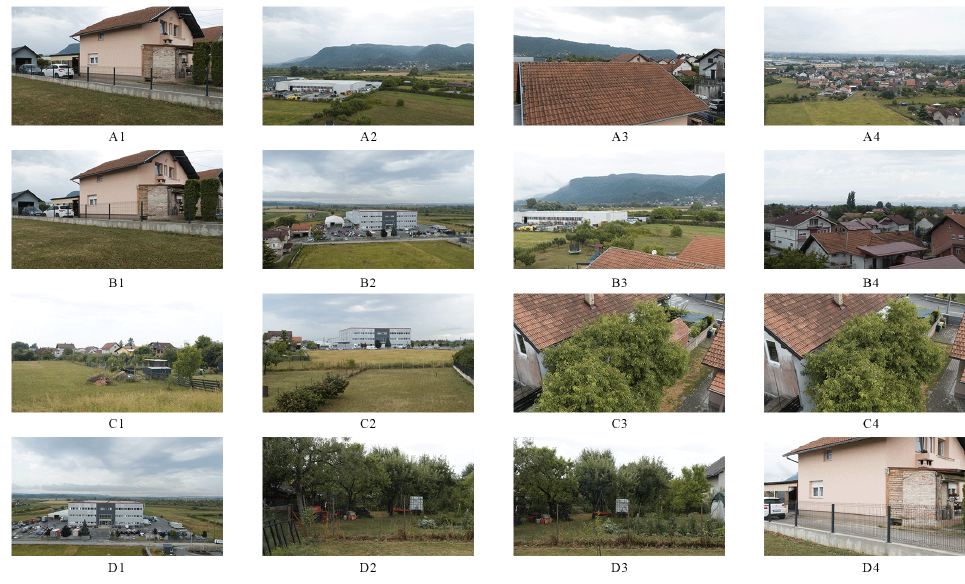
Figure 3. Class A, B, C, and D